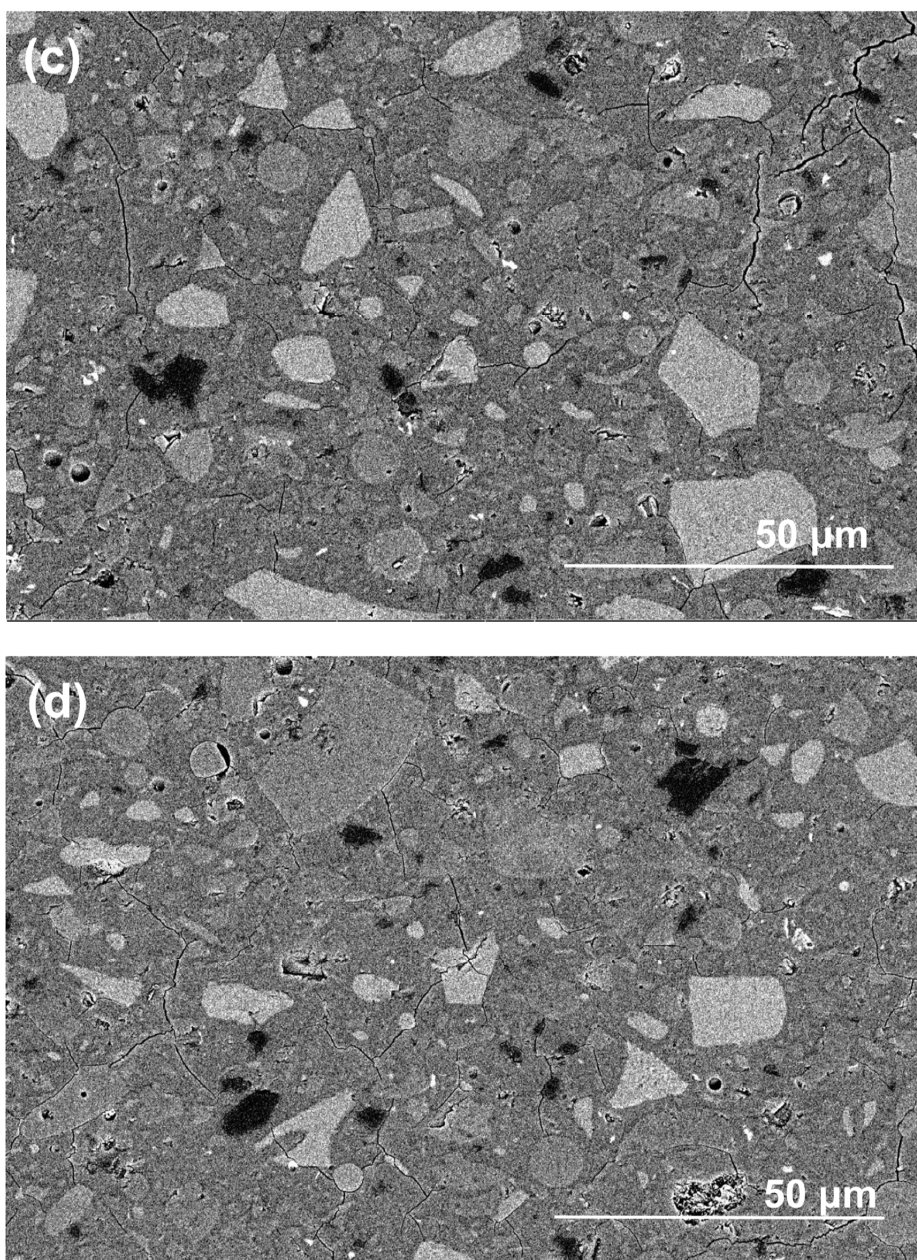
Figure 10. Backscattered electron (BSE) images of ( a , b ) part 3 in exposed NHFS and ( c , d ) part 1 in exposed NSFS after efflorescence ageing.